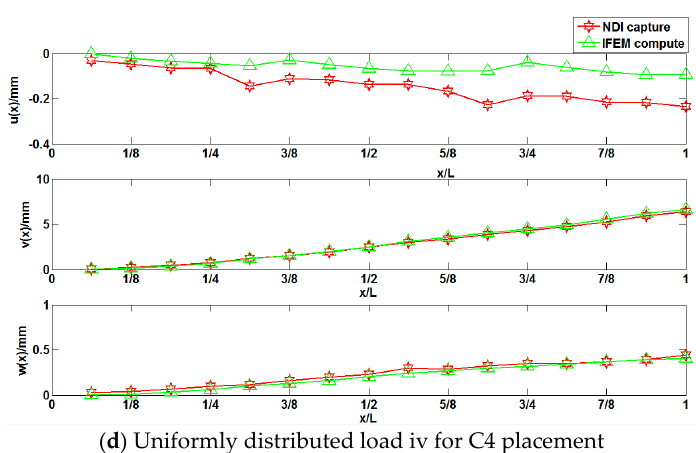
Figure 9. Comparisons among iFEM calculations for different placements of sensors and NDI measurements for two different loads. Table 8. Loads for static tests (loads expressed in kg and displacements expressed in mm).